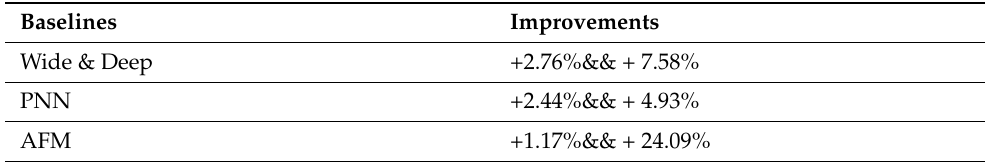
Table 2. Performance growth of GAFM compared to other